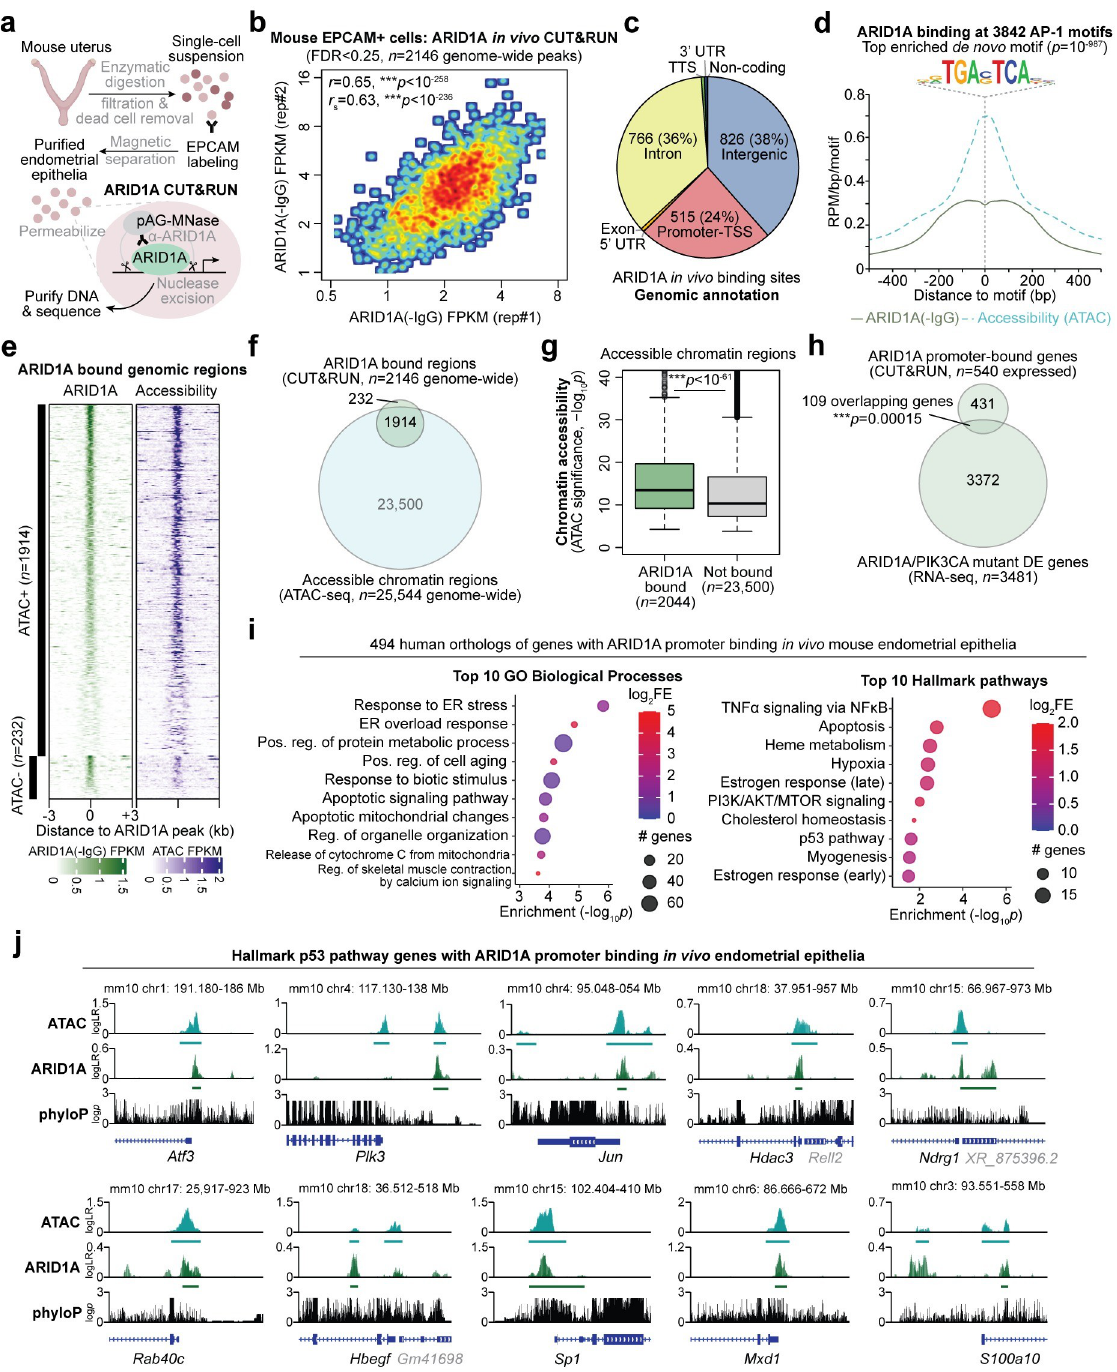
Fig 6. Analysis of ARID1A chromatin interactions in mouse endometrial epithelia in vivo . a , Diagram of experimental workflow for measuring ARID1A chromatin interactions in vivo . Endometrial epithelial cells are purified from mouse uterus by positive enrichment with labeling and magnetic beads. Purified cells were then subject to CUT&RUN for ARID1A or IgG negative control. b , Correlation of ARID1A binding signal (compared to IgG) in vivo across 2146 genomic regions with significant binding detected (FDR < 0.25) in two independent experiments. c , Genomic annotation of 2146 ARID1A bound genomic regions in vivo . d , ARID1A binding and accessibility profiles at 3842 bound AP-1/bZIP motifs, using the top de novo enriched motif among ARID1A genome-wide binding sites in vivo , TGA(G/C)TCA. e , Heatmap of ARID1A binding and chromatin accessibility signal across 2146 genomic regions with significant ARID1A binding detected, segregated by accessibility. f , Overlap of ARID1A bound regions and accessible chromatin regions. g , Chromatin accessibility quantified at